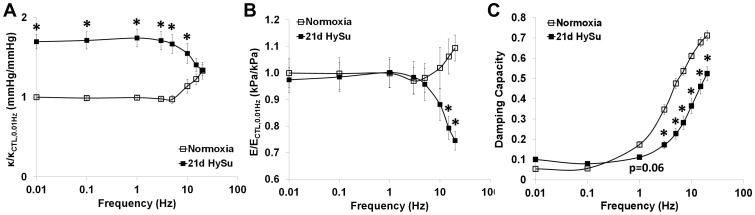
Frequency-dependent dynamic structural stiffness κ (A), dynamic elastic modulus E, (B) and damping capacity D (C) in control and 21d HySu PAs.N  =  5 per group. Means ± Standard Errors. * p<0.05 vs. control.